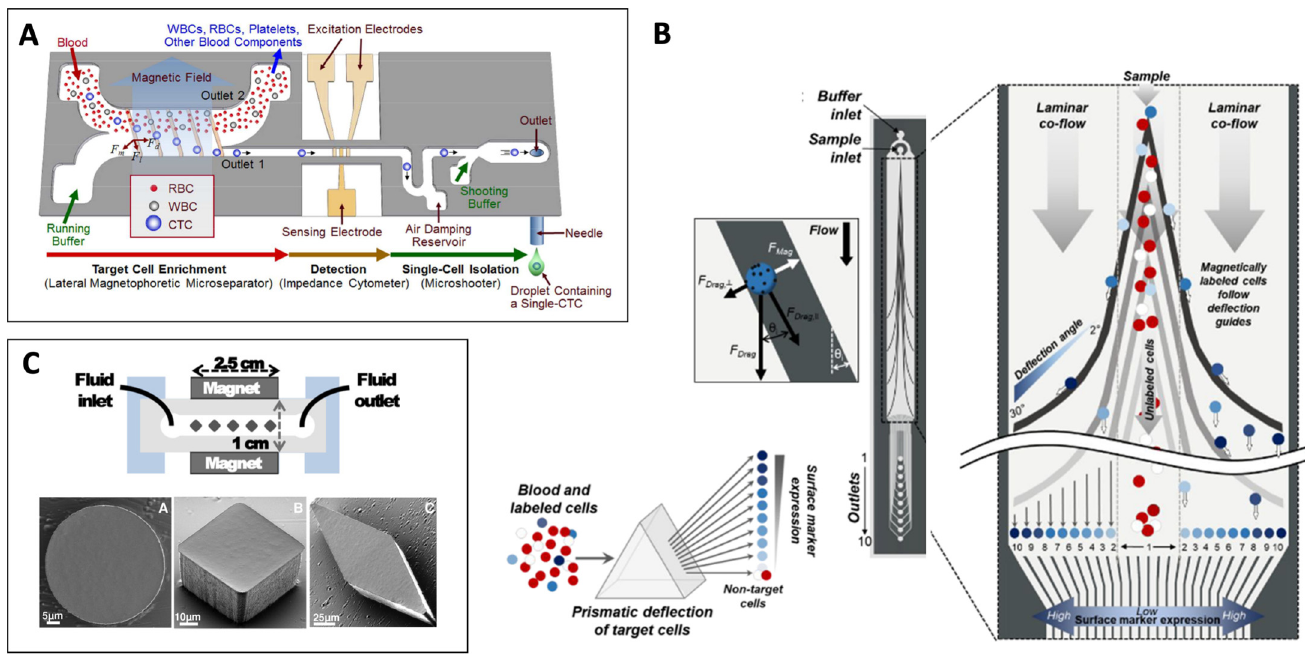
Figure 13. Microfluidic devices with soft-patterned ferromagnetic structures. ( A ) Two-step cascade platform: Lateral magnetophoretic separator and a microdispenser synchronized with electrical impedance detection. Reprinted with permission from [186]. Copyright 2016 American Chemical Society. ( B ) Prismatic deflection based on surface marker expression. Reprinted with permission from [187]. Copyright 2018 American Chemical Society. ( C ) Schematic top view of a microsystem integrating soft iron-PDMS pillars in the channel and scanning electron microscope images of the magnetic structures. Reprinted from [188], with the permission of AIP Publishing.